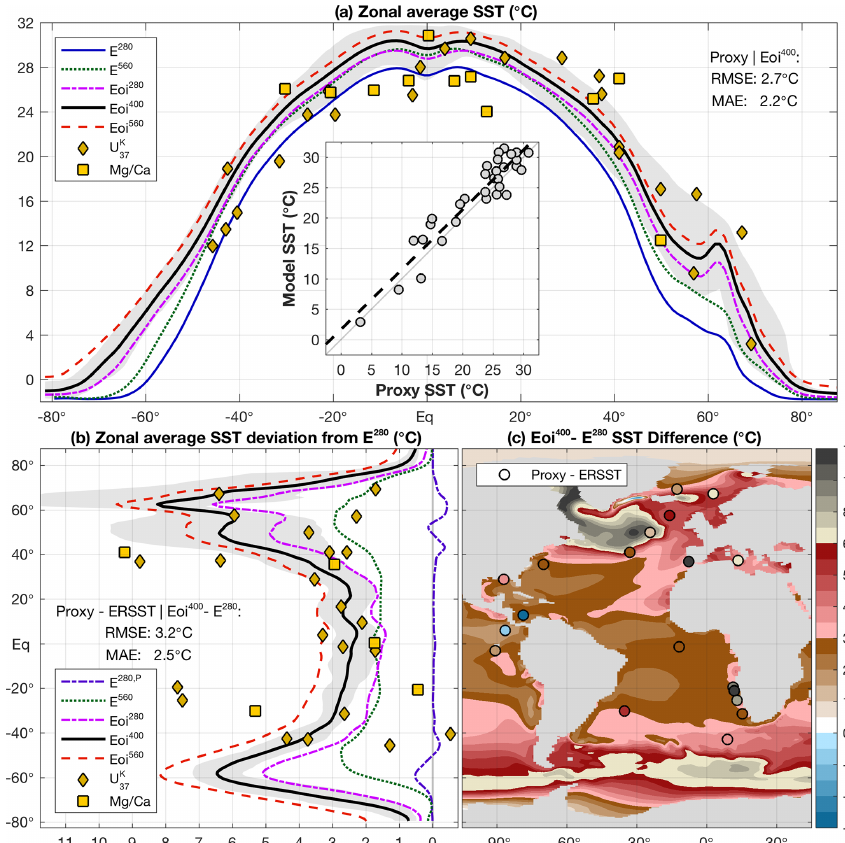
(cid:48) ; squares: Mg / Ca) versus model-derived 37